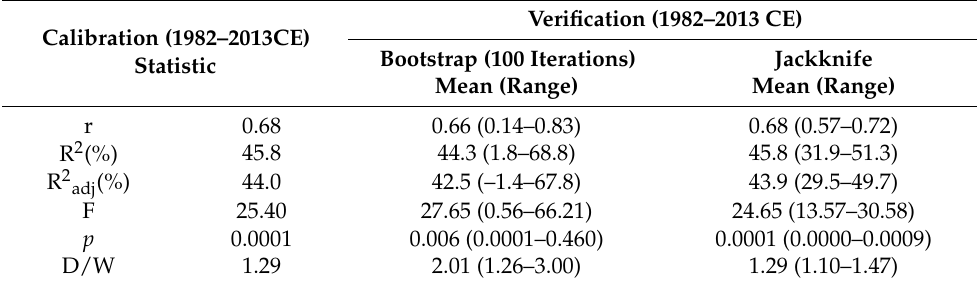
Table 4. Results of the bootstrap and jackknife verifications.